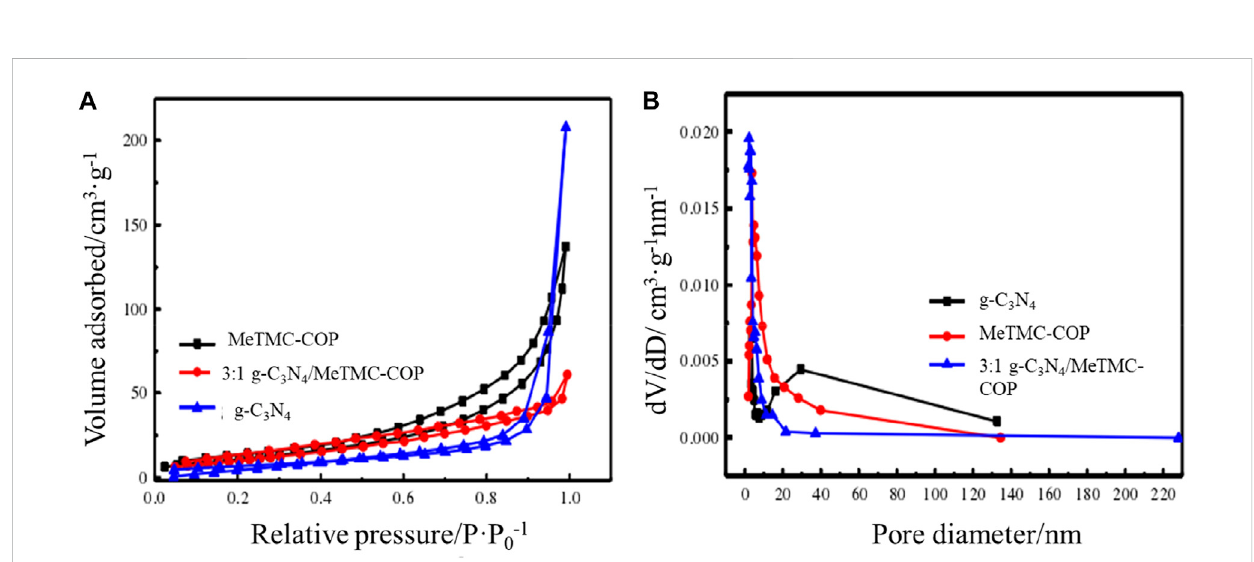
FIGURE 5 Nitrogen adsorption-desorption isotherm (A) and pore size distribution diagram (B) of g-C 3 N 4 , 3:1 g-C 3 N 4 /MeTMC-COP,